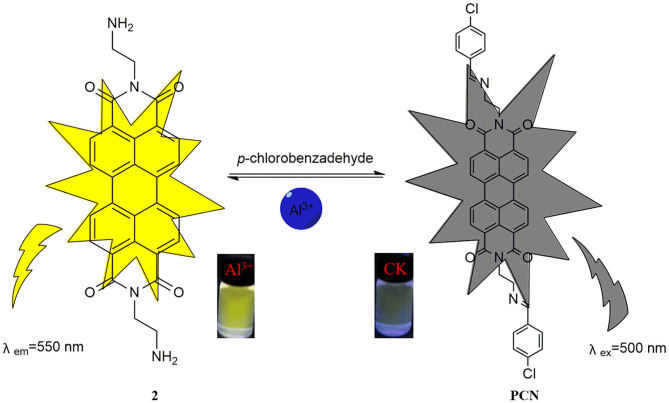
Proposed sensing mechanism toward Al3+.